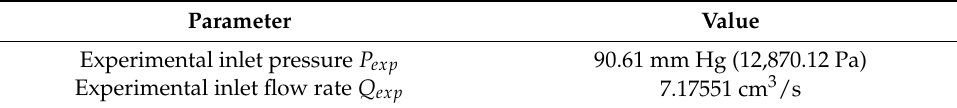
Table 3. Experimentally obtained input parameters for simulation of CHN13.